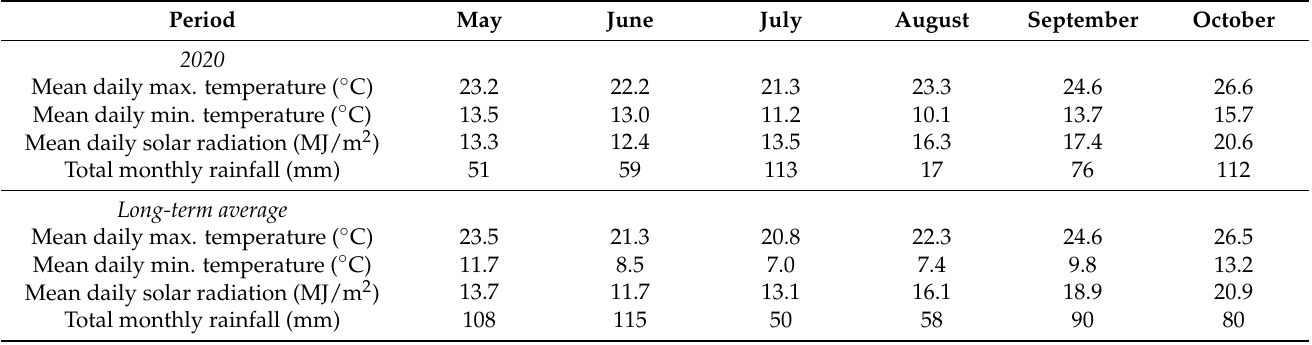
Table 1. Average monthly daily temperatures and daily solar radiation, and total monthly rainfall in the study with the strawberries in Queensland. Long-term average temperatures (1965 to 1990), solar radiation (2004 to 2019), and rainfall (2007 to 2019) also